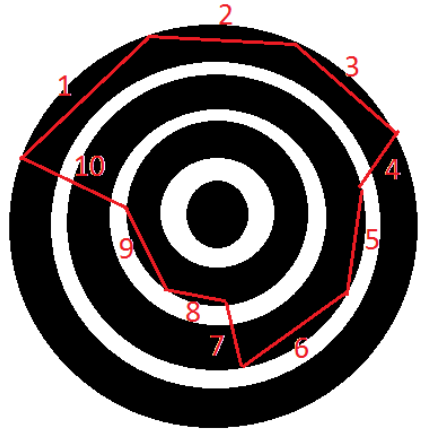
Figure 2 . A closed string excitation of an LLM spacetime geometry. The magnons on the closed string are